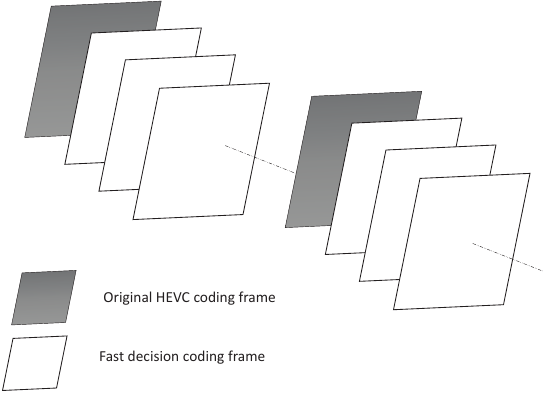
Figure 5. The statistical parameters are estimated with online